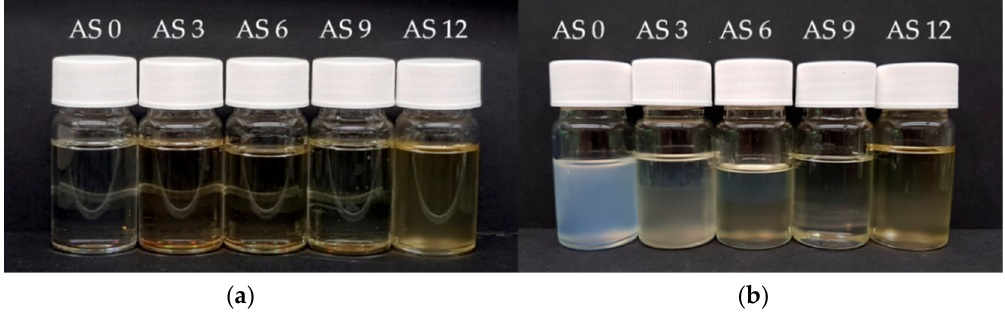
Figure 11. ( a ) Photograph of additive solutions AS 0 to AS 12 at room temperature. ( b ) All solutions after CP measurements. The solutions were not stirred for 24 h until the polymer rich phase (lower) macroscopically separated from the phase with low molecular weight species.